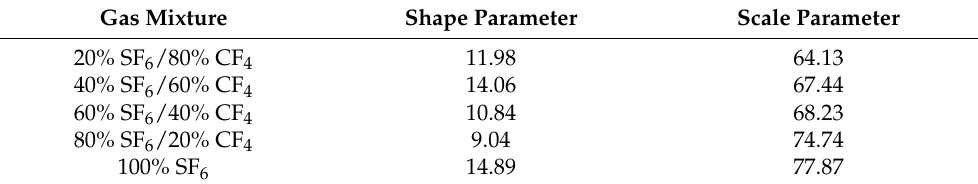
Figure 6. Weibull fitting of flashover voltage with a finger-type electrode system. Table 1. Shape and scale parameters with a finger-type electrode